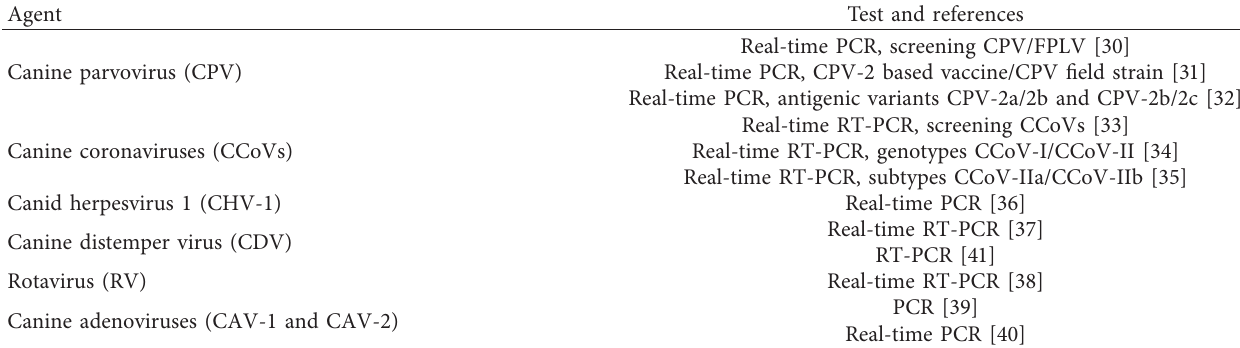
Table 1: PCR protocols used for the detection and characterisation of viral pathogens.